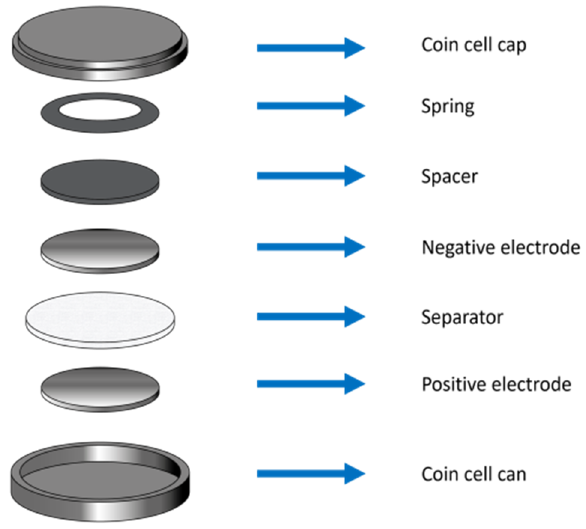
Figure 15. Schematic of the symmetric CR2032 coin cell and its components.